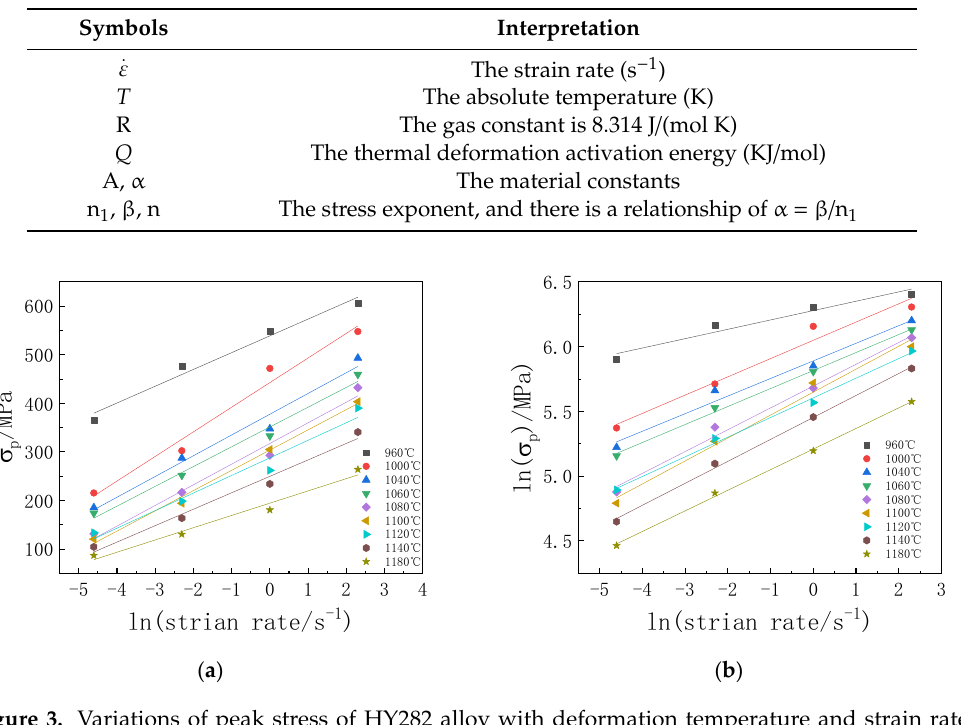
Figure 4. Linear relationship of ( a ) ln(strain rate)- ln(sinh( α σ p )); ( b ) ln(sinh( α σ p ))- T .